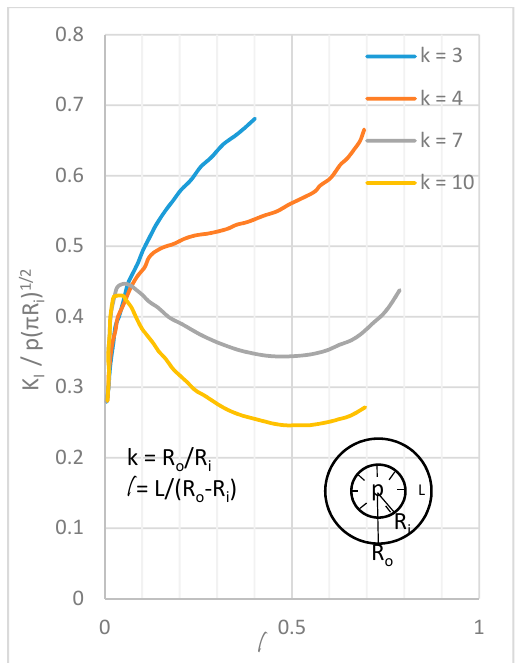
Figure 10. Variation of Stress Intensity Factor with respect to crack length [85].